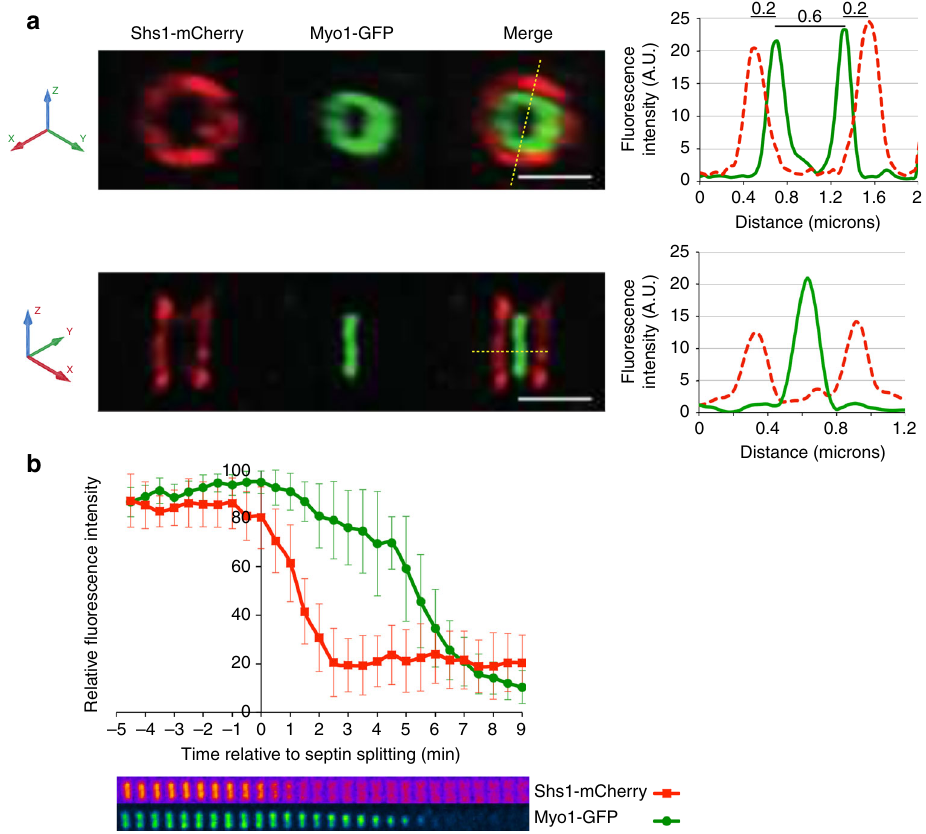
Fig. 1 Septin ring splitting and CAR constriction are spatially and temporally separated events. a Logarithmically growing cells expressing Shs1-mCherry and Myo1-GFP were fi xed and processed for SIM. The image shows an example of split septin rings sandwiching the CAR. Scale bar: 2 μ m. Graphs show the quanti fi cation of fl uorescence intensities along the yellow dotted line in the merge. Dotted red line: Shs1-mCherry; green line: Myo1-GFP. A.U.: Arbitrary Units. b Same cells as in a were imaged live every min through their cell cycle. Quanti fi cation of fl uorescence intensities associated to Shs1-mCherry and Myo1-GFP around the time of septin ring splitting (time 0). Fluorescence intensity associated to septin and myosin II has been quanti fi ed by ImageJ in cells undergoing cytokinesis (graph; red squares: Shs1-mCherry; green circles: Myo1-GFP) and then related to the highest fl uorescence intensity of each structure in a given cell. Plots show average values ( n = 15). Error bars: s.d. Cropped images beneath the graph show the behavior of septin ring and CAR during this time frame in one representative cell. Shs1 was pseudocolored with the Fire plugin of Image J to re fl ect signal intensity (orange/red signals mean higher fl uorescence intensity than magenta